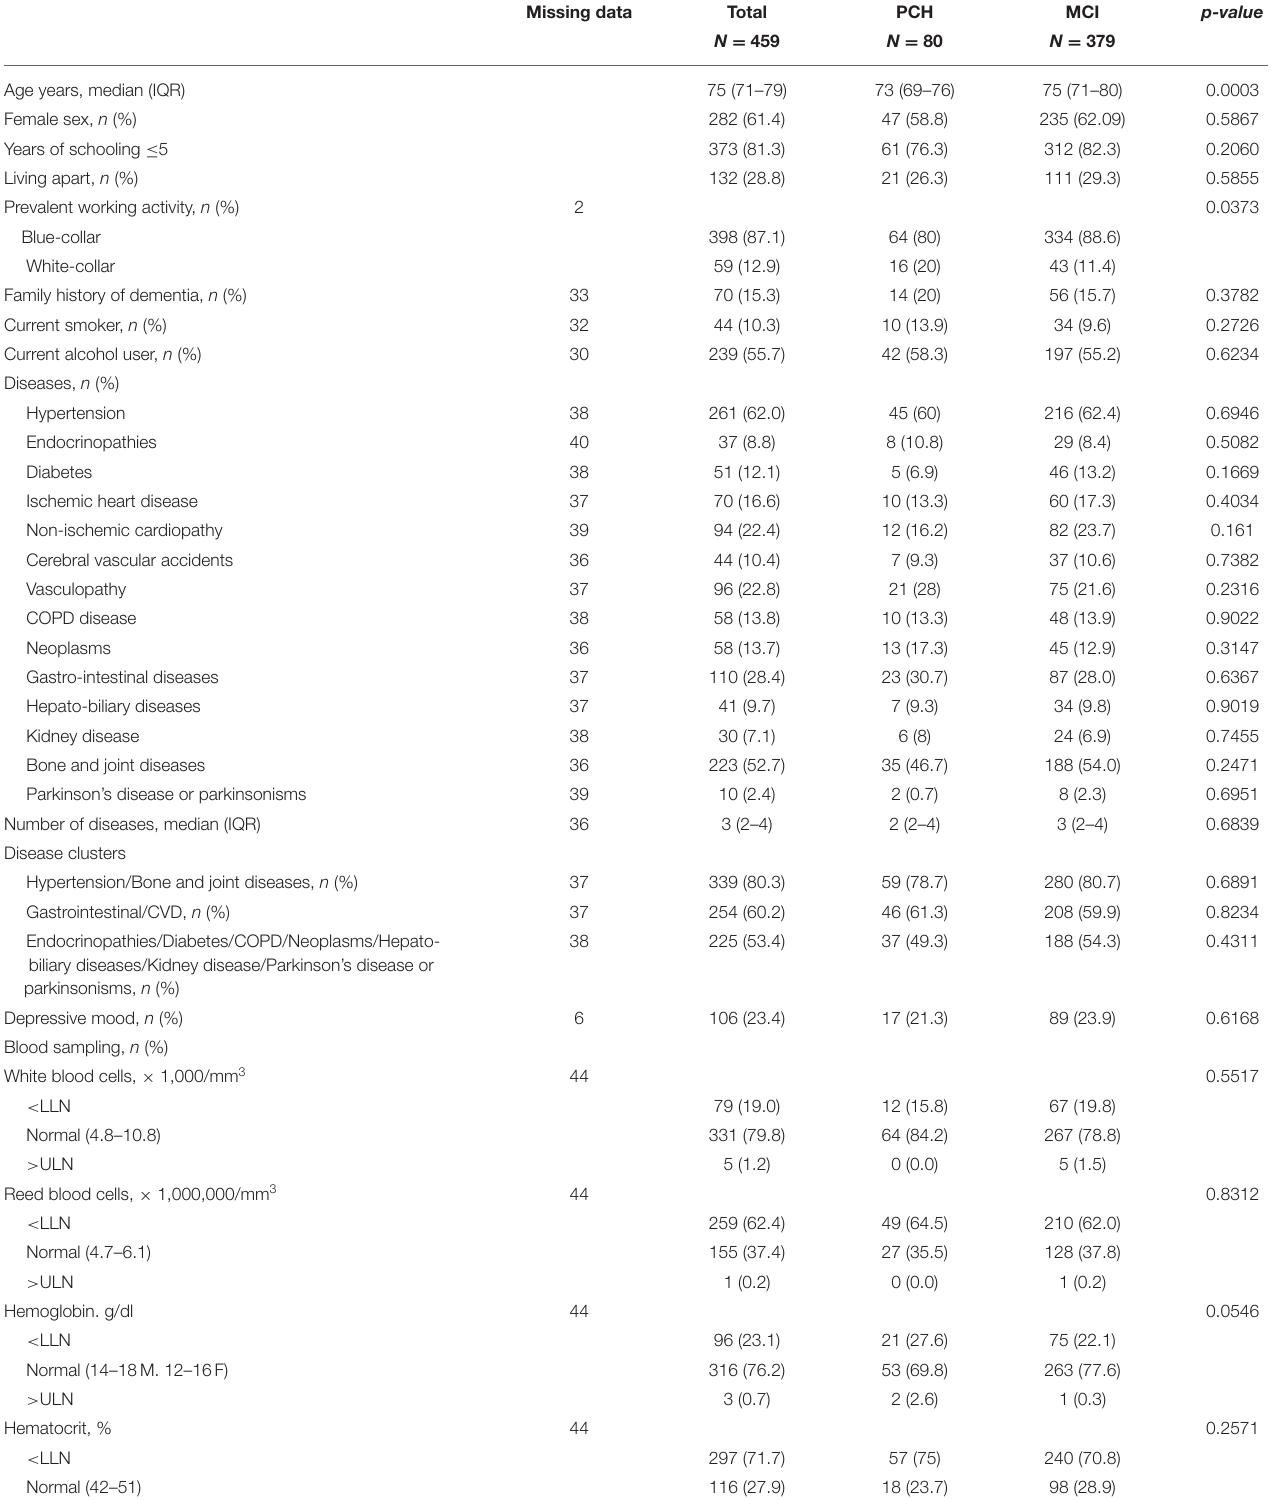
TABLE 1 | Participants’ characteristics by cognitive status at